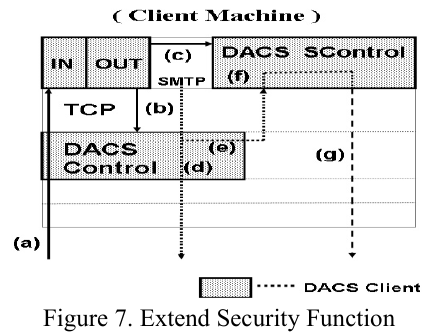
Figure 7. Extend Security Function